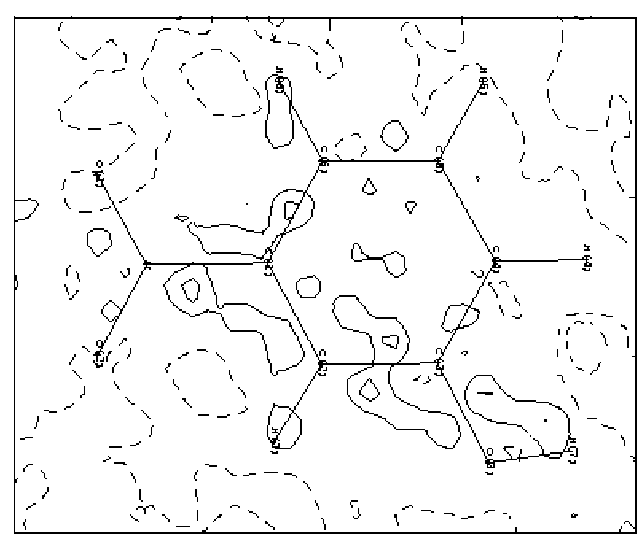
rrr -= . Contour map is 0.05 eÅ -3 multores